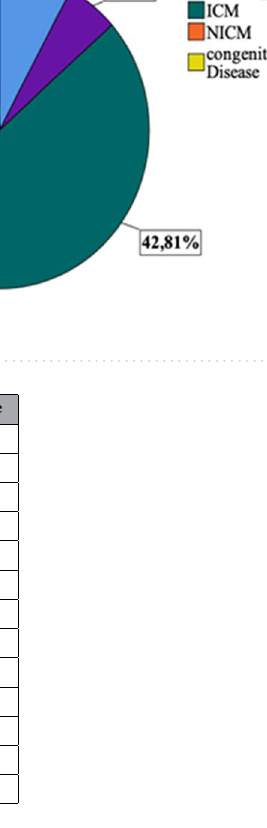
Table 3. Baseline characteristics of WCD patients stratified by cardiomyopathy